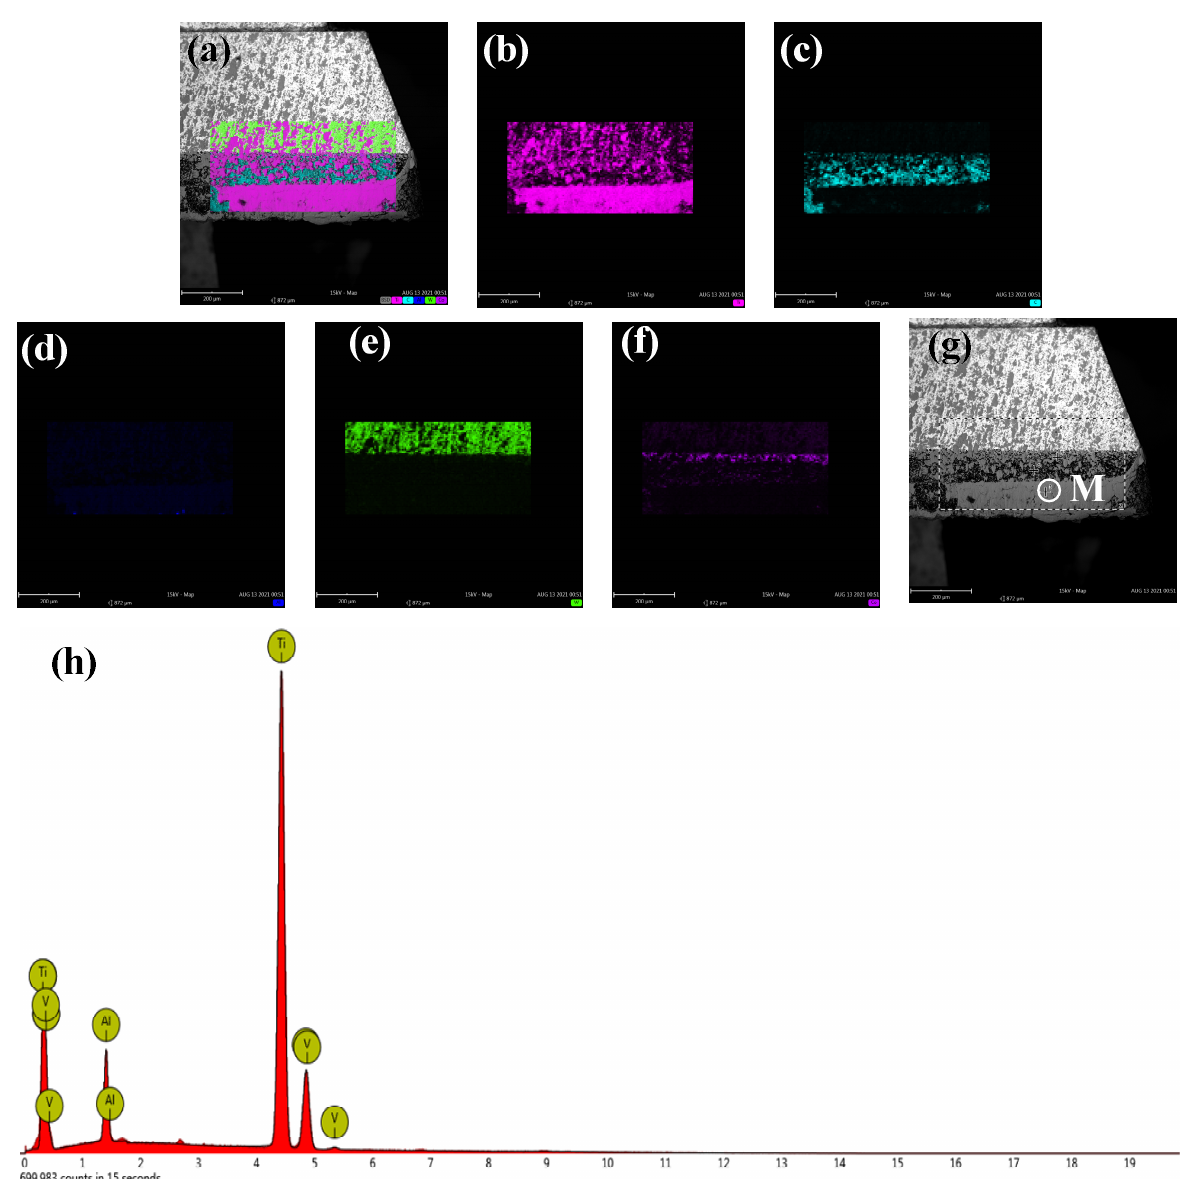
Figure 6. Element distribution and EDS of the flank face in ultrasonic-assisted milling: ( a ) combined map; ( b ) titanium; ( c ) carbon; ( d ) aluminum; ( e ) tungsten; ( f ) cobalt; ( g ) flank face; ( h ) EDS analysis of point M.